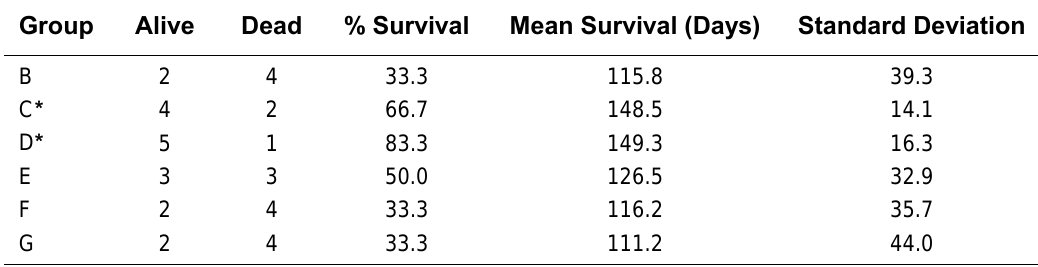
Survival of Rats in Days of Placebo Group (B) and the Treatment Groups